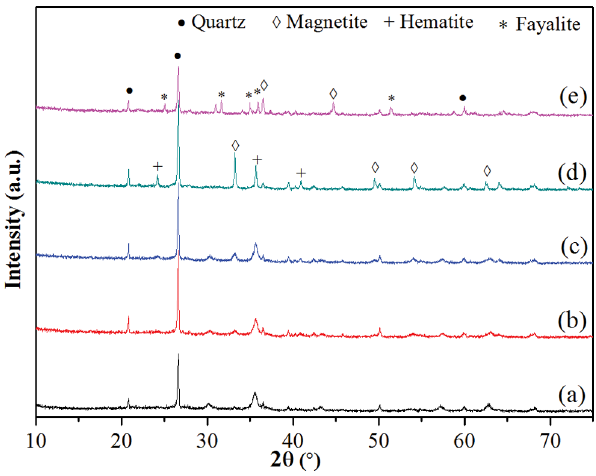
Figure 1. XRD pattern of five adsorbent composites: (a) uncalcined Fe 3 O 4 -HBC composite, (b) 400 6 C under air, (c)